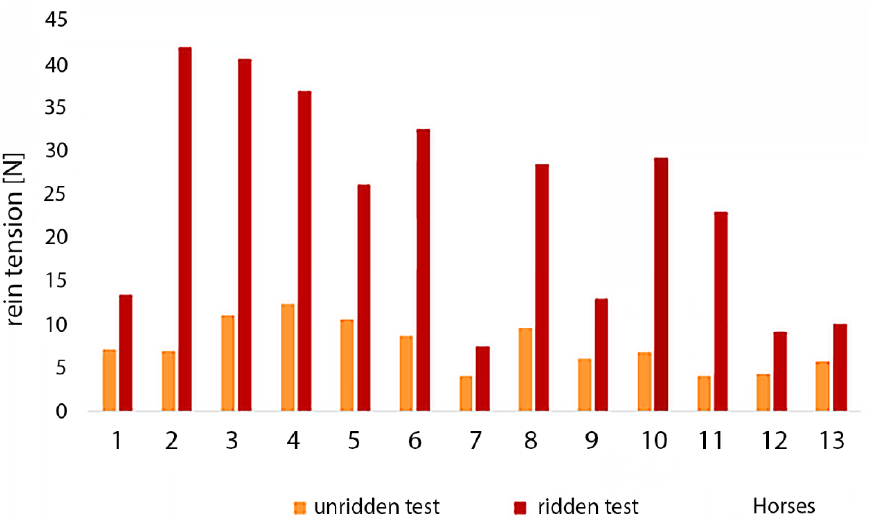
Figure 6. Rein tensions of each of 13 horses for each state; for each horse, except of Horse 7, the rein tension in the unridden test was significantly ( p < 0.05) lower than in the ridden